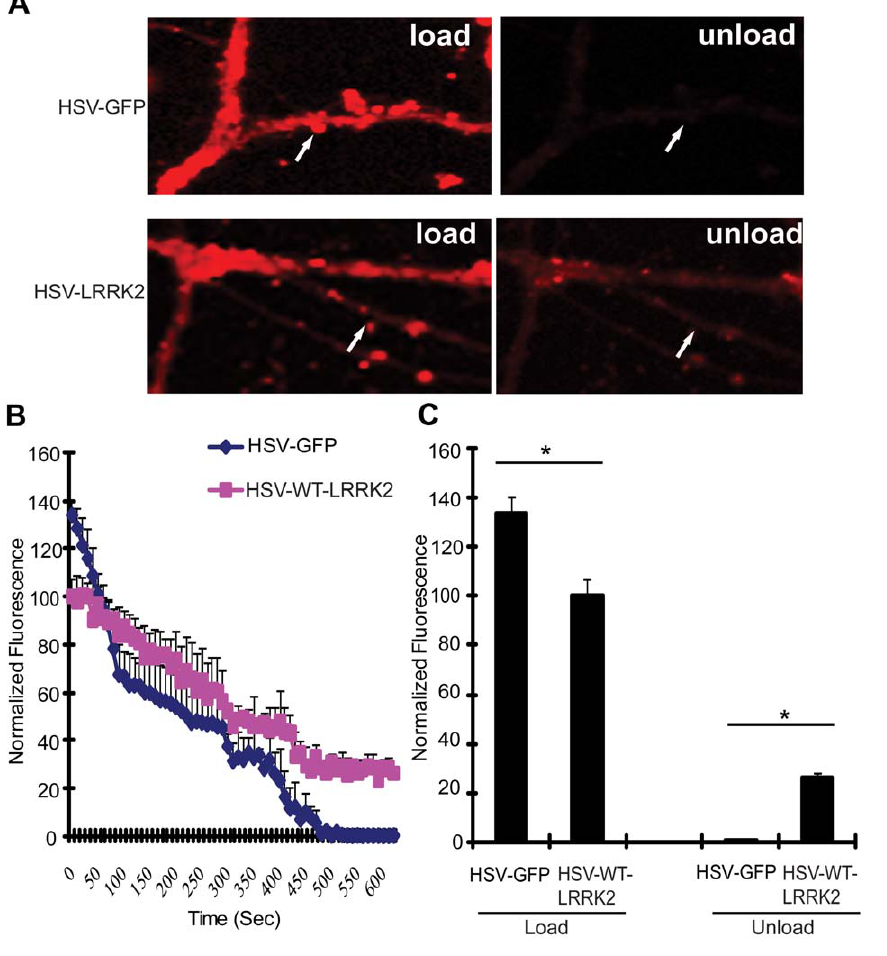
Figure 6. Expression of LRRK2 causes vesicular trafficking defects in neurons. (A) Hippocampal neuronal synapses transduced with HSV- WT-LRRK2/CMV-eGFP or HSV-PrPUC/CMV-eGFP as a control following FM4–64 dye loading by synaptic vesicle endocytosis and unloading by synaptic vesicle exocytosis. Arrows indicate synaptic boutons. (B) Dynamic real-time quantification of FM4–64 fluorescence intensity in synaptic boutons following dye loading and unloading over a 10 min period. Notice reduced initial loading and delayed release of the FM dye due to WT LRRK2 expression (C) Quantification of FM4–64 fluorescence intensity in synaptic boutons following dye loading at time point 0 sec and unloading at time point 480 sec. Data represent the mean 6 SEM from three independent experiments (15 boutons for each experiment). Data were analyzed